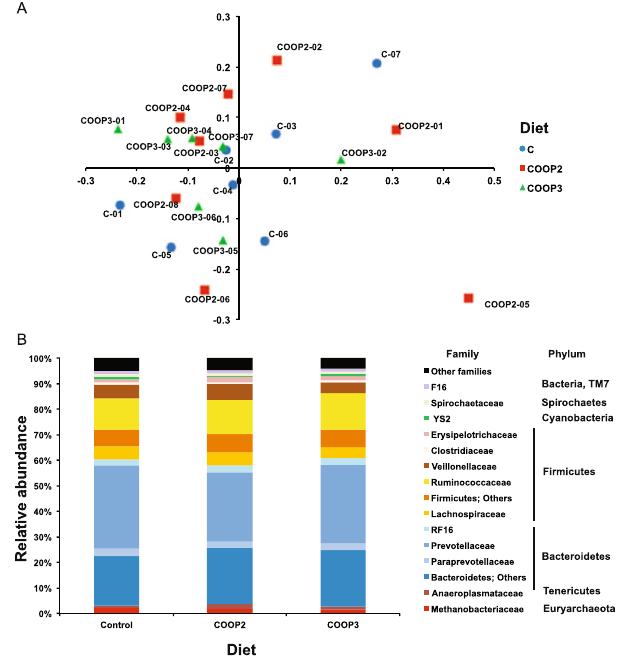
Figure 1. Rumen microbiota of ewes. Rumen microbiota are labeled respective to the ewe diet regimen (C = control diet; COOP2 = control diet added with olive oil pomace extracted with a two-phase procedure; COOP3 = control diet added with olive oil pomace extracted with a three-phase procedure). ( A ) ß-diversity, non-metric MDS plot. ( B ) Prokaryotic community composition of ewe RL at family level. Only families whose relative abundance was higher than 0.8% are shown.